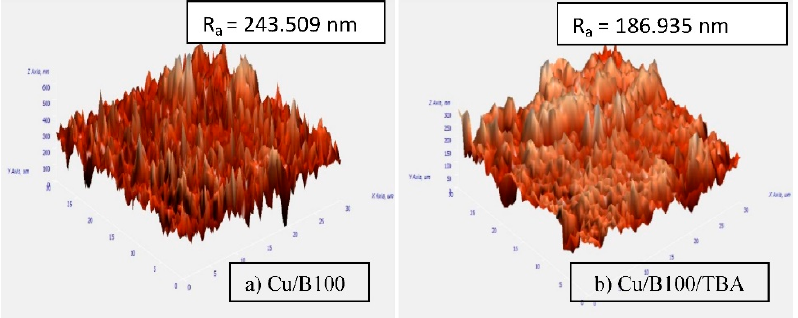
Figure 21. AFM (Atomic Force Microscopy) images of copper surface after exposure to biodiesel and biodiesel with tert-butylamine (TBA) additives [152].